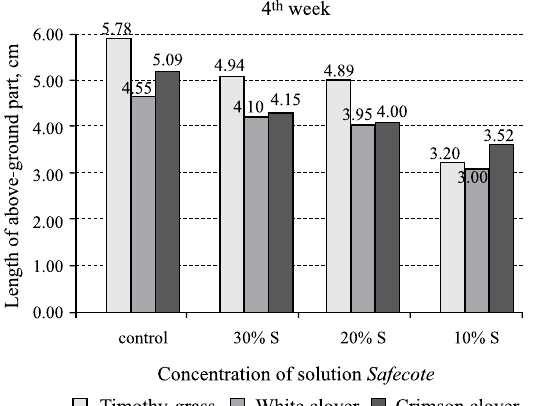
Fig. 6. Length of above-ground part of grass vegetation after 4 th week of growth